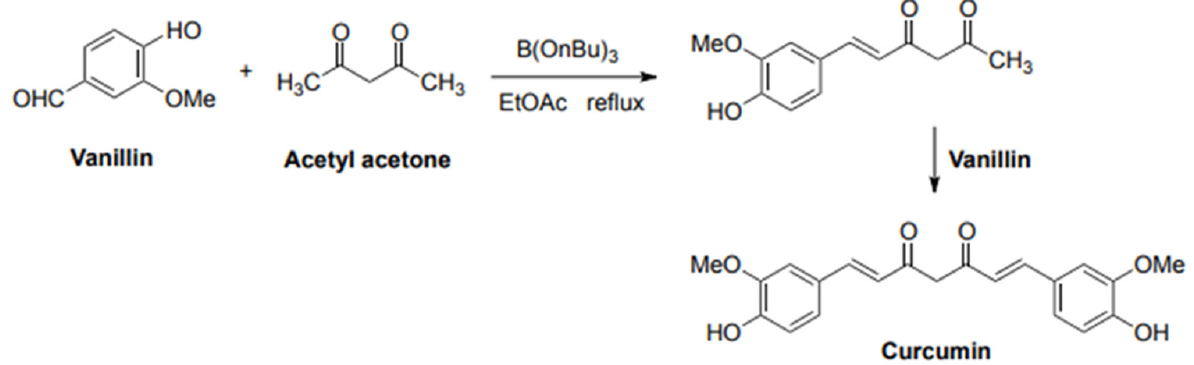
Figure 1. Curcumin synthesis by condensation of acetylacetone and vanillin.